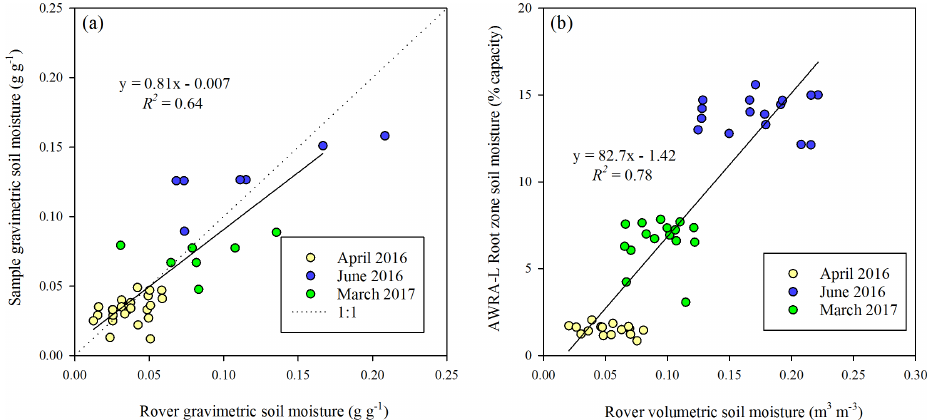
Figure 13. Broad-scale rover survey gravimetric soil moisture (9km resolution) versus point sample gravimetric soil moisture (a) and broad- scale rover survey soil moisture (9km resolution) versus AWRA-L root zone soil moisture (5km